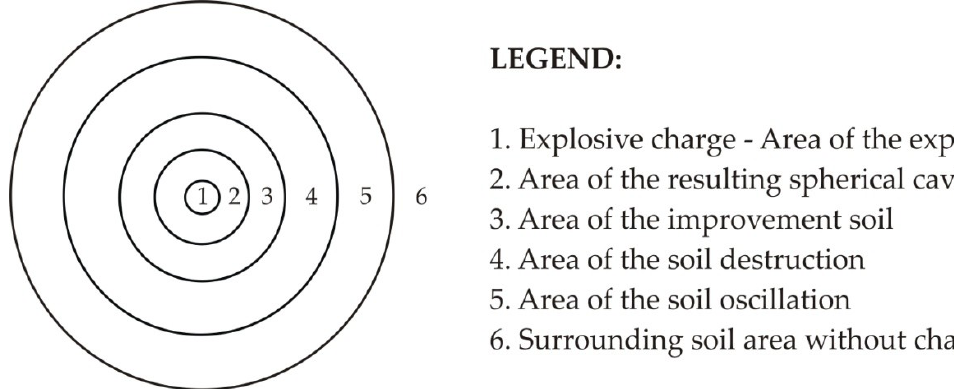
Figure 2. Performance of explosion in soft rock.